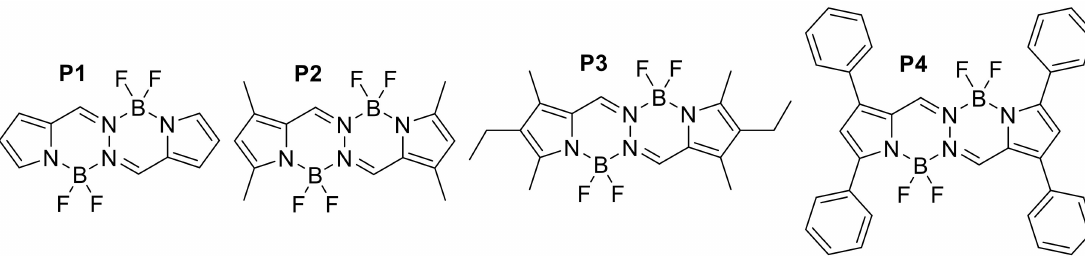
Figure A8. Various BOPHYs.